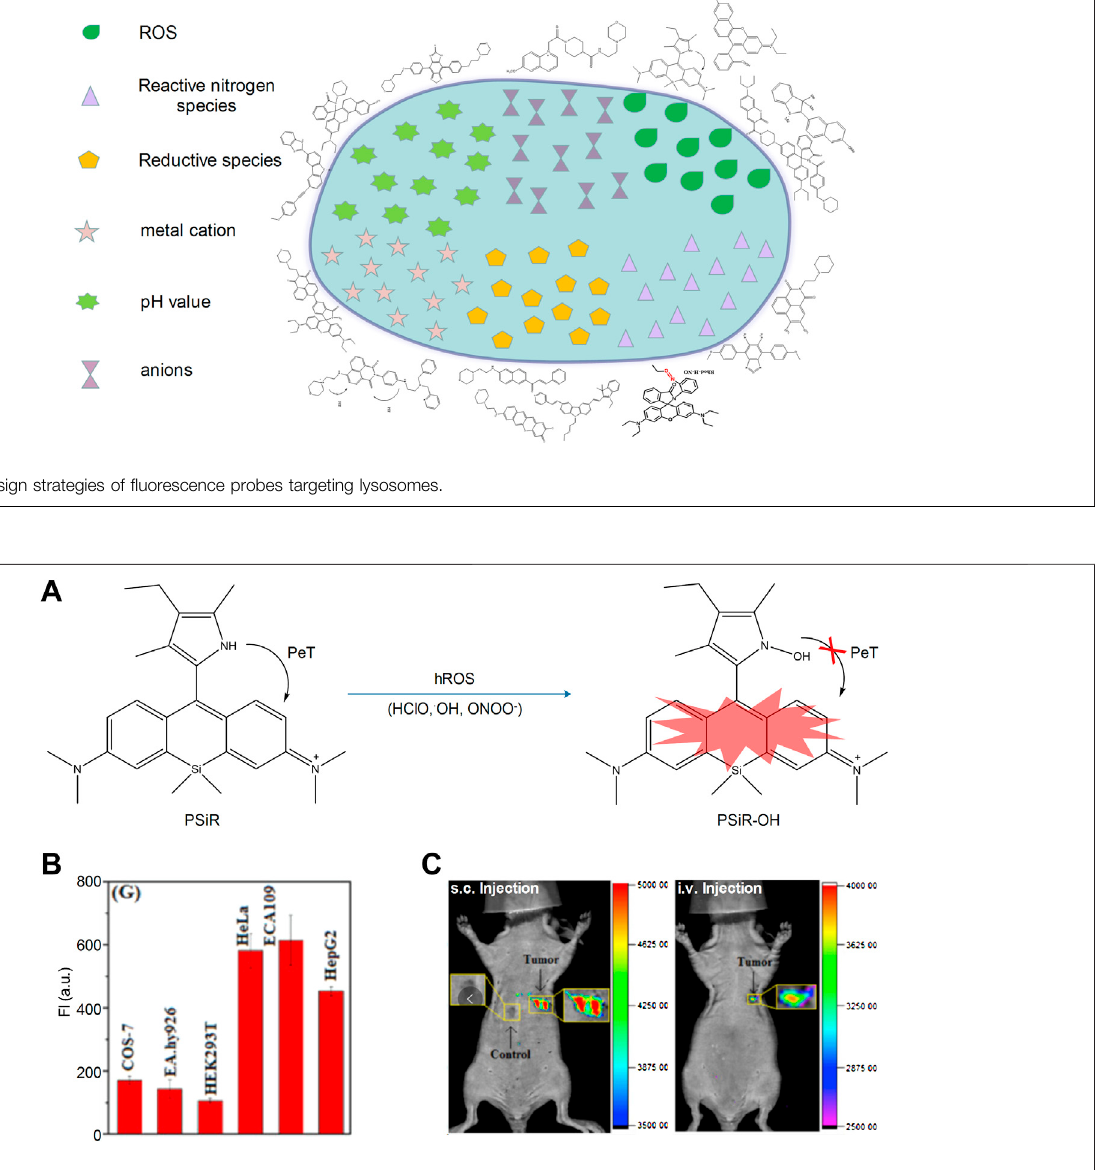
Frontiers in Pharmacology |